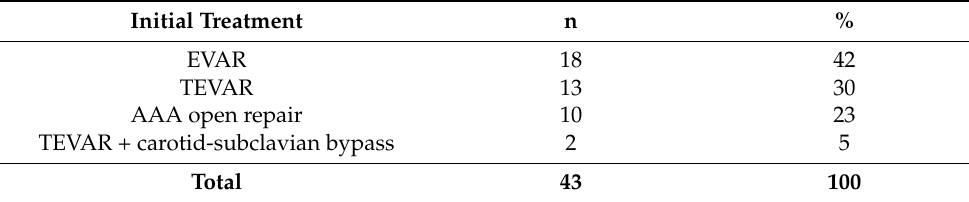
Table 2. Initial treatment of previous vascular diseases of AGI patients.